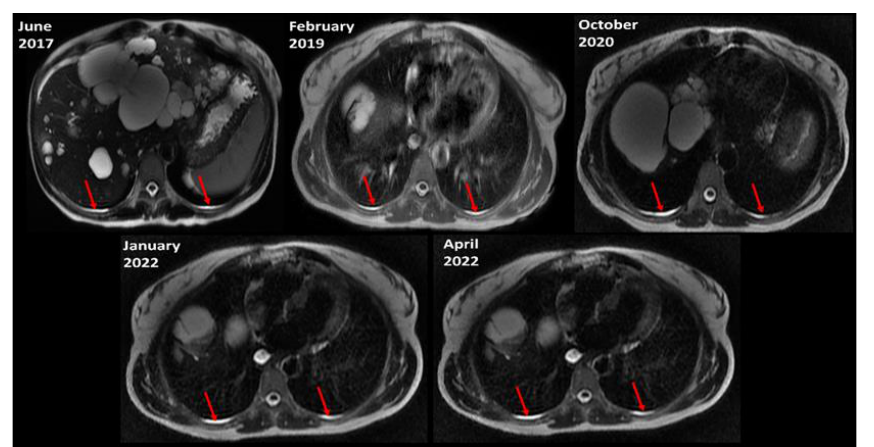
Figure 3. Pleural effusions (red arrows) are similar on successive axial T2-weighted MRI scans of the same subject over 5 years.